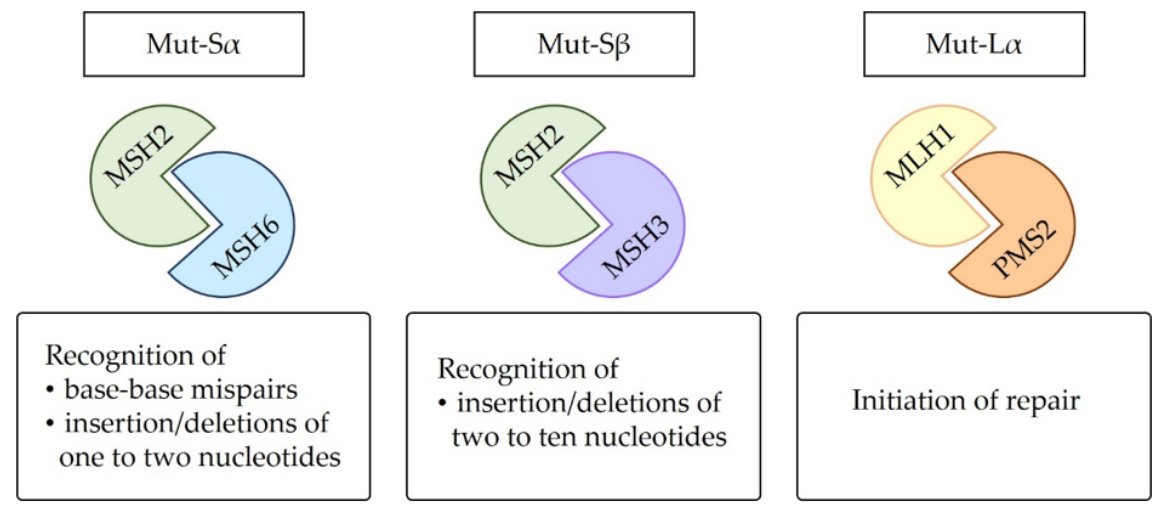
Figure 2. Functional complexes formed by the human MMR proteins and their functions.